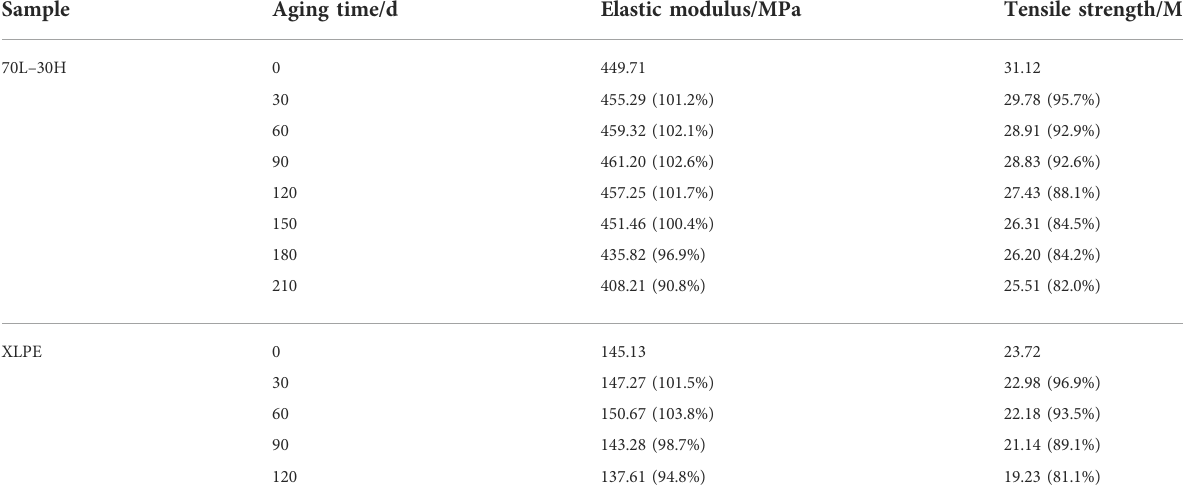
TABLE 2 Variation of mechanical properties for each material with thermal aging